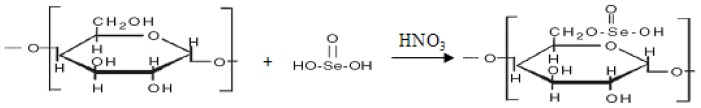
Selenylation mechanism of seleno-polysaccharide.